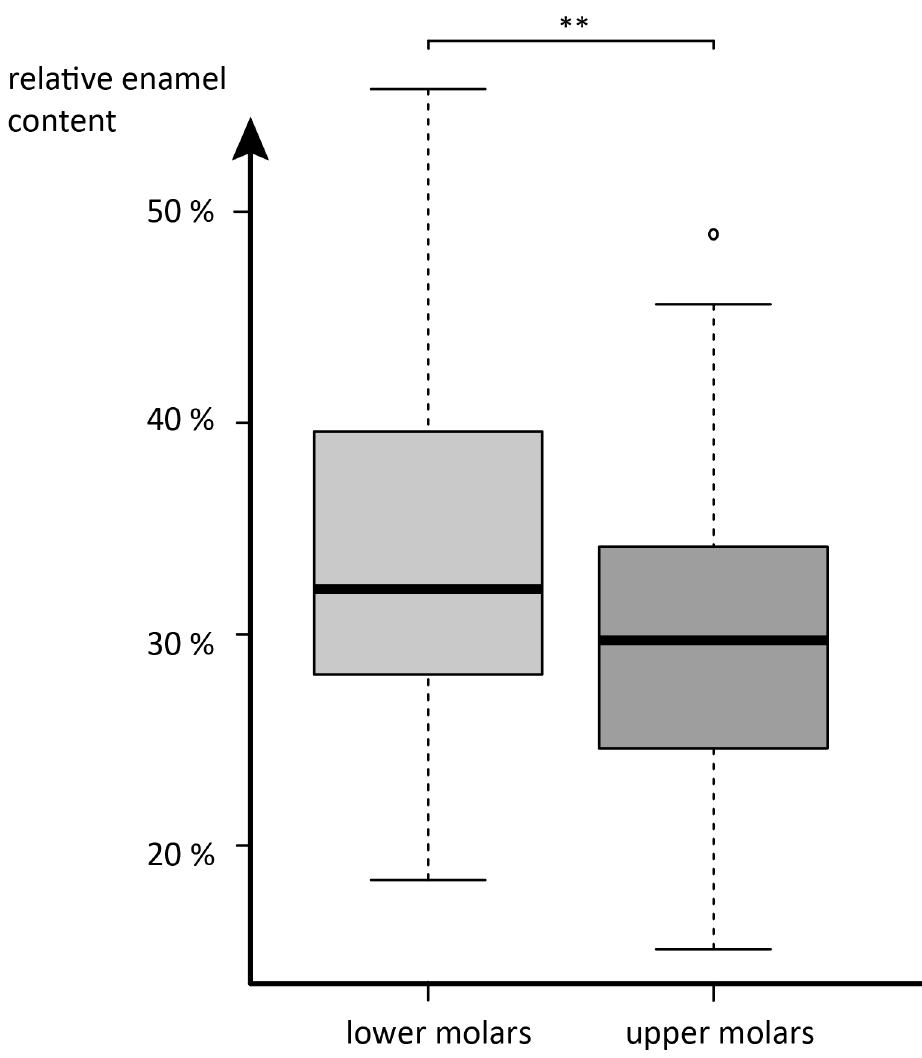
Fig 2. Boxplots of pooled relative enamel content of all upper versus all lower molars. * : p = 0.05, *** : p = 0.001, n.s. = not significant (all p-values from post-hoc Tukey